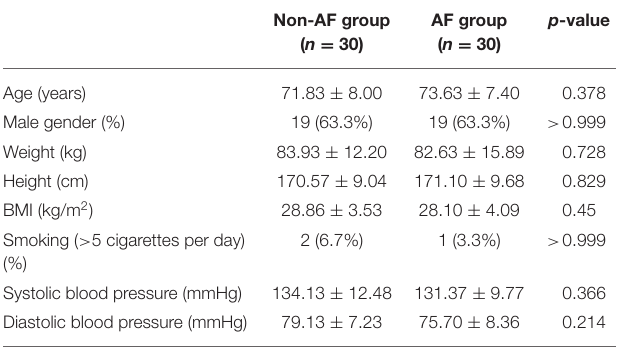
TABLE 1 | Baseline demographics of the study population.